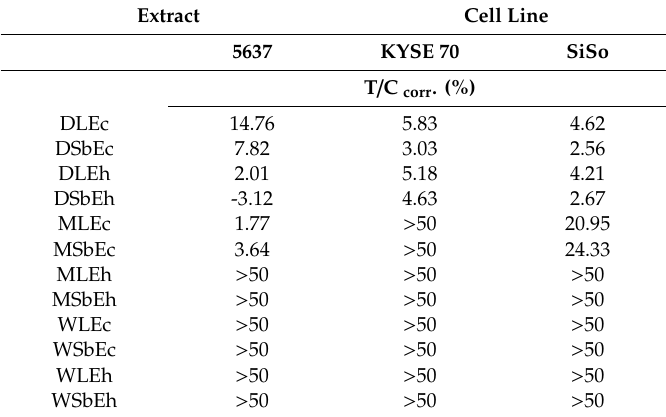
Table 4. Antiproliferative activity T / C corr . (%) of extracts (50 µ g / mL) on 5637, KYSE 70 and SiSo cell lines in primary screening.